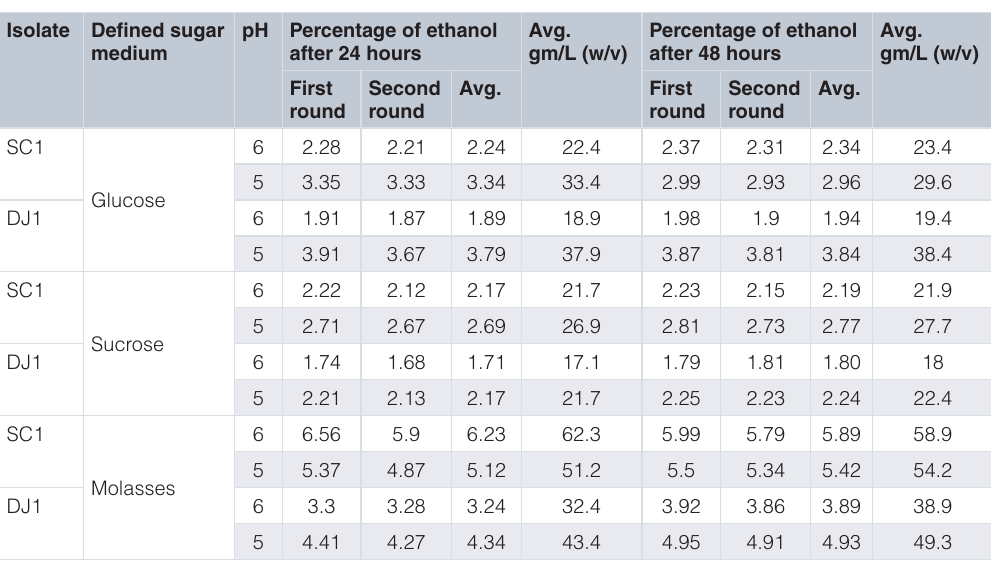
Table 3. Alcohol production from defined sugars by yeast isolate SC1 and DJ1. Isolate Defined sugar medium